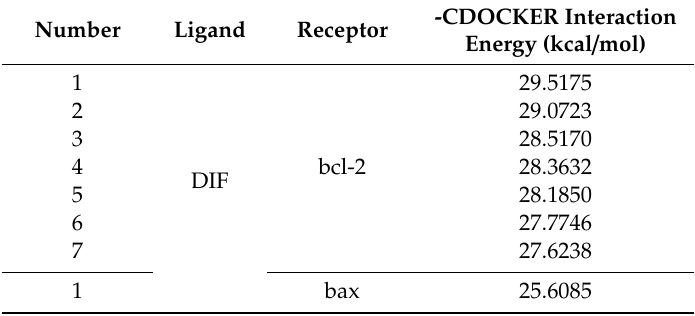
Table 2. CDOCKER interaction energy values of the binding sites of DIF to bcl-2 and bax